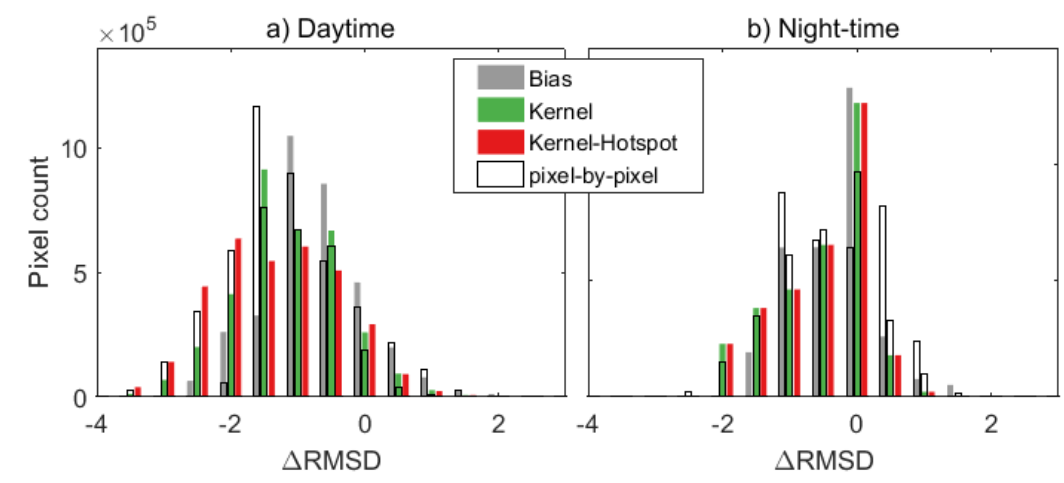
Figure 6. Histograms of variation of the root mean square differences (ΔRMSD) between SEVIRI and MODIS (in K) after applying the bias correction (grey) and after applying the angular correction with the Kernel model (green) and the Kernel-Hotspot model (red), for ( a ) daytime and ( b ) night-time only observations. The open bars are the respective values for the pixel-based model.